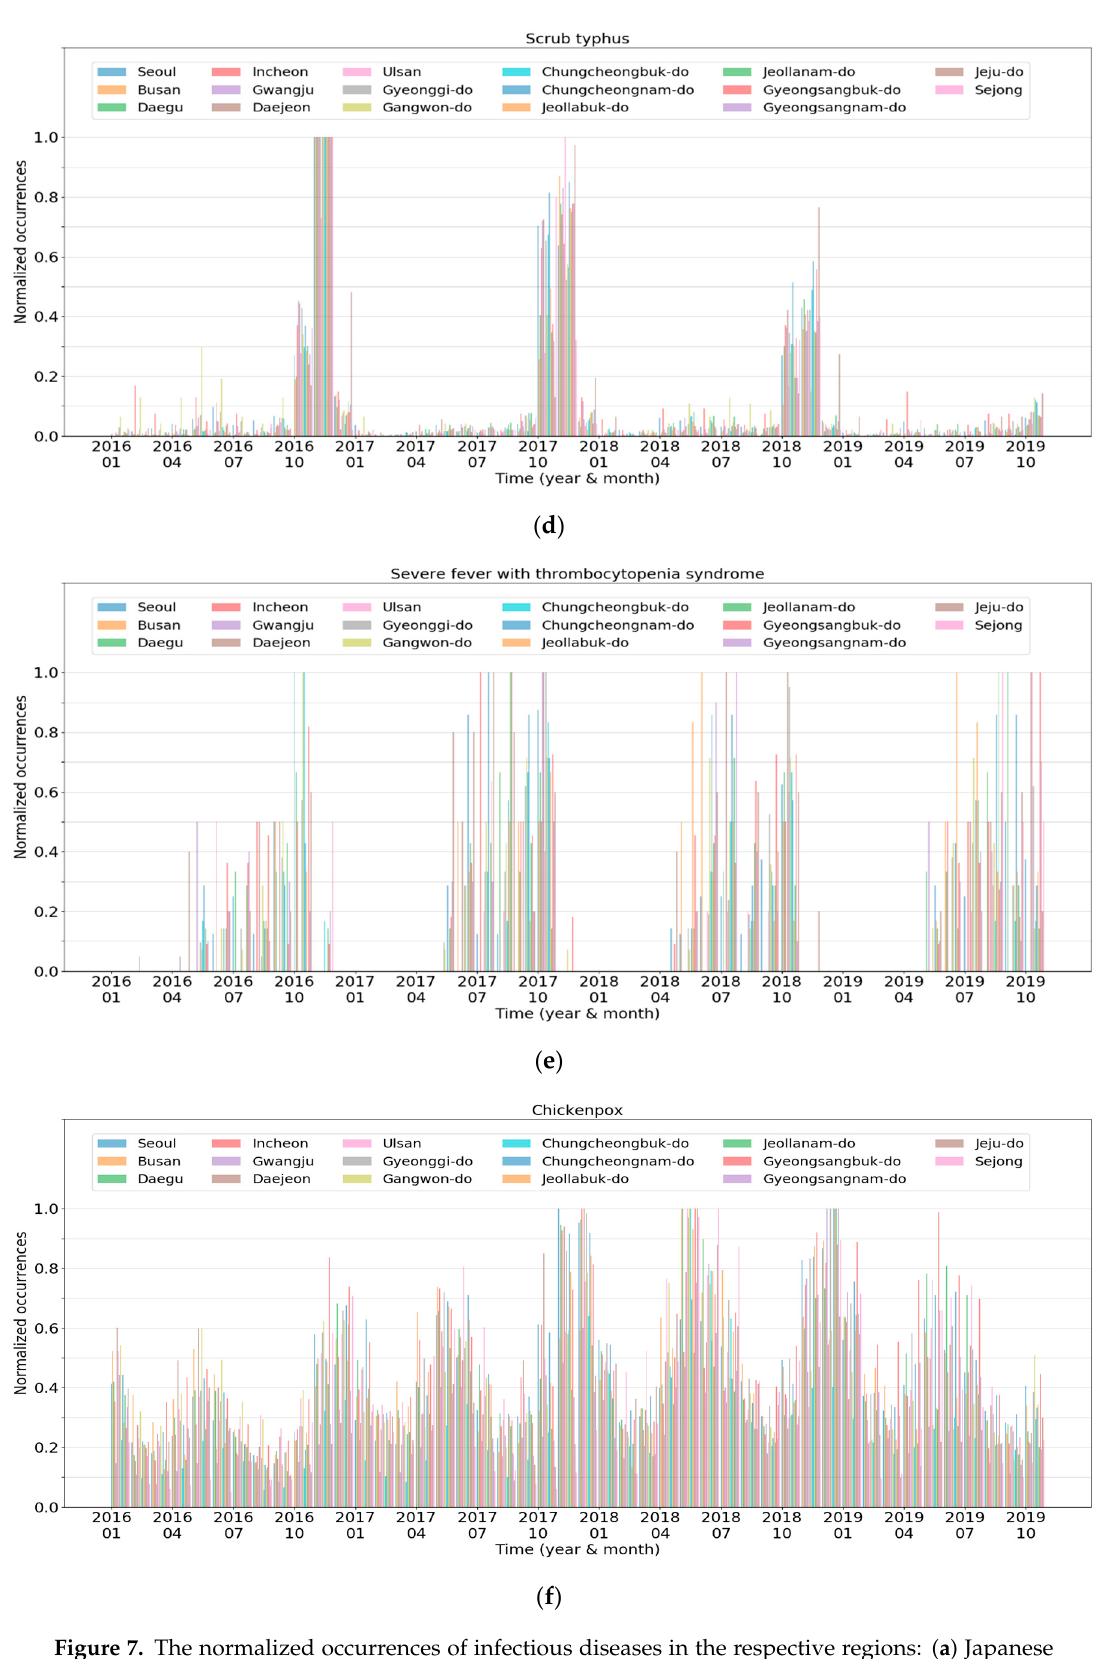
Figure 7. The normalized occurrences of infectious diseases in the respective regions: ( a ) Japanese encephalitis; ( b ) measles; ( c ) acute hepatitis B; ( d ) scrub typhus; ( e ) severe fever with thrombocytopenia syndrome; ( f ) chickenpox.